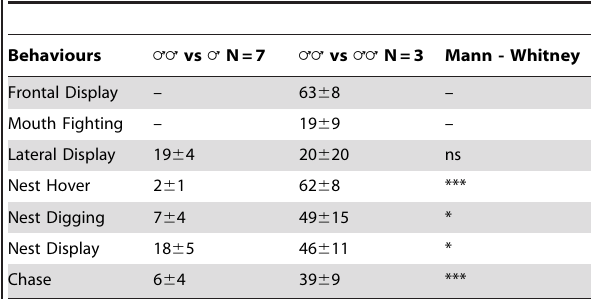
Table 6. Mean percentage ( 6 SE) of co-occurrence between behaviour and production of sounds.